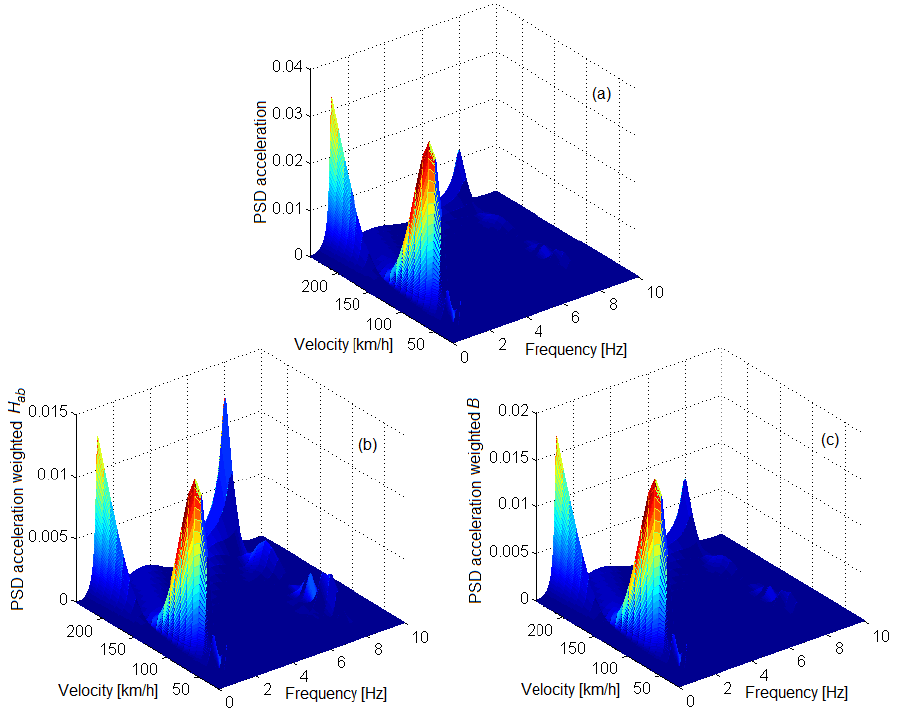
Figure 6. Correlation between ride comfort index N MV and ride comfort index W z .Power spectral density of acceleration (PSD acceleration) in reference point C in (m/s 2 ) 2 /Hz: ( a ) unweighted; ( b ) weighted with weighting function H ab ; ( c ) weighted with weighting function B.